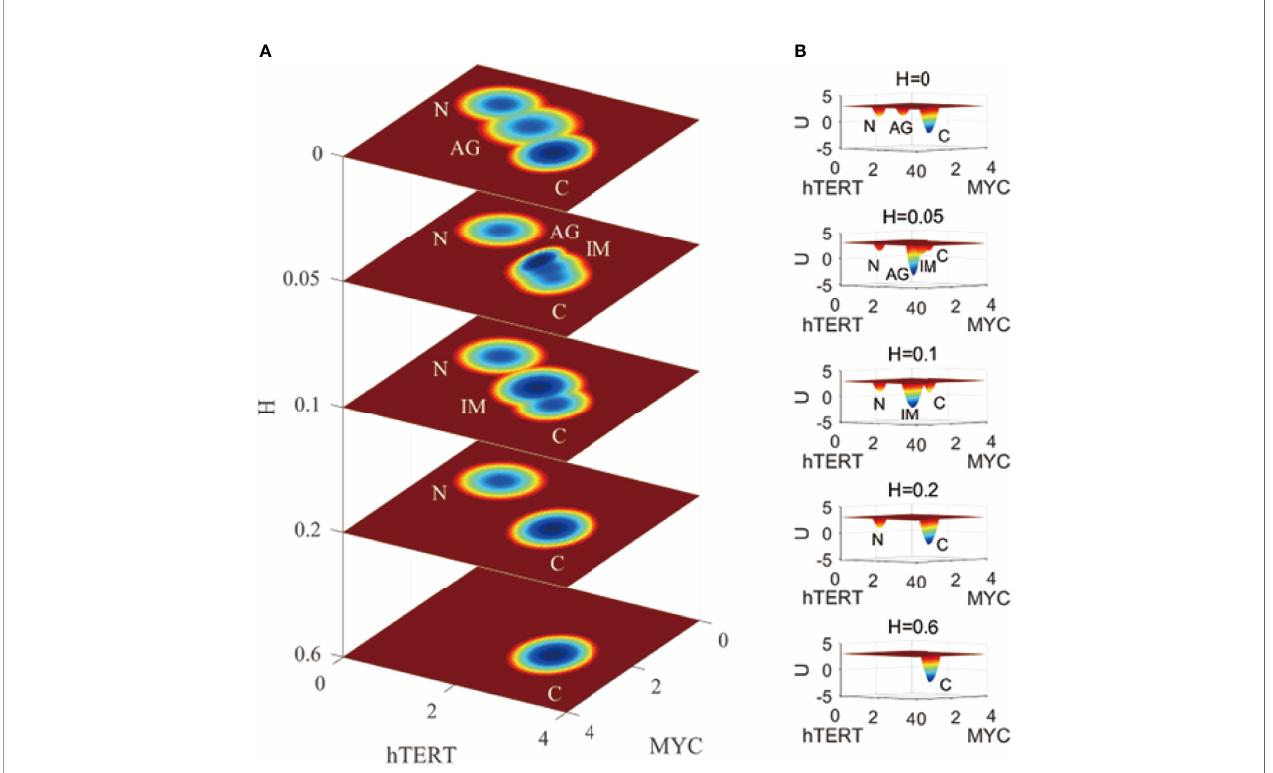
FIGURE 3 | A comparison of the landscape topography variations fi r IGC with Helicobacter pylori infection. The X and Y-axes represent the gene expression levels of hTERT and MYC, respectively, while the Z-axis represents the variations in H. H denotes the degree of Helicobacter pylori infection. N, AG, IM, and C represent the normal, atrophic gastritis, intestinal metaplasia, and gastric cancer states, respectively. (A) is the comparison of the 2-dimensional landscape. (B) is the comparision of the 3-dimensional